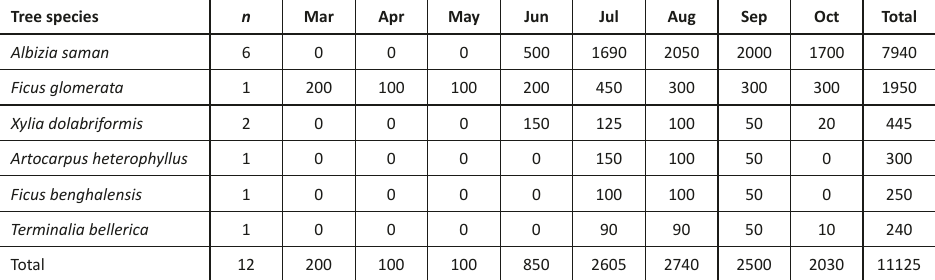
Table 3. The number of Flying Foxes recorded on roost trees in Myeik. Tree species